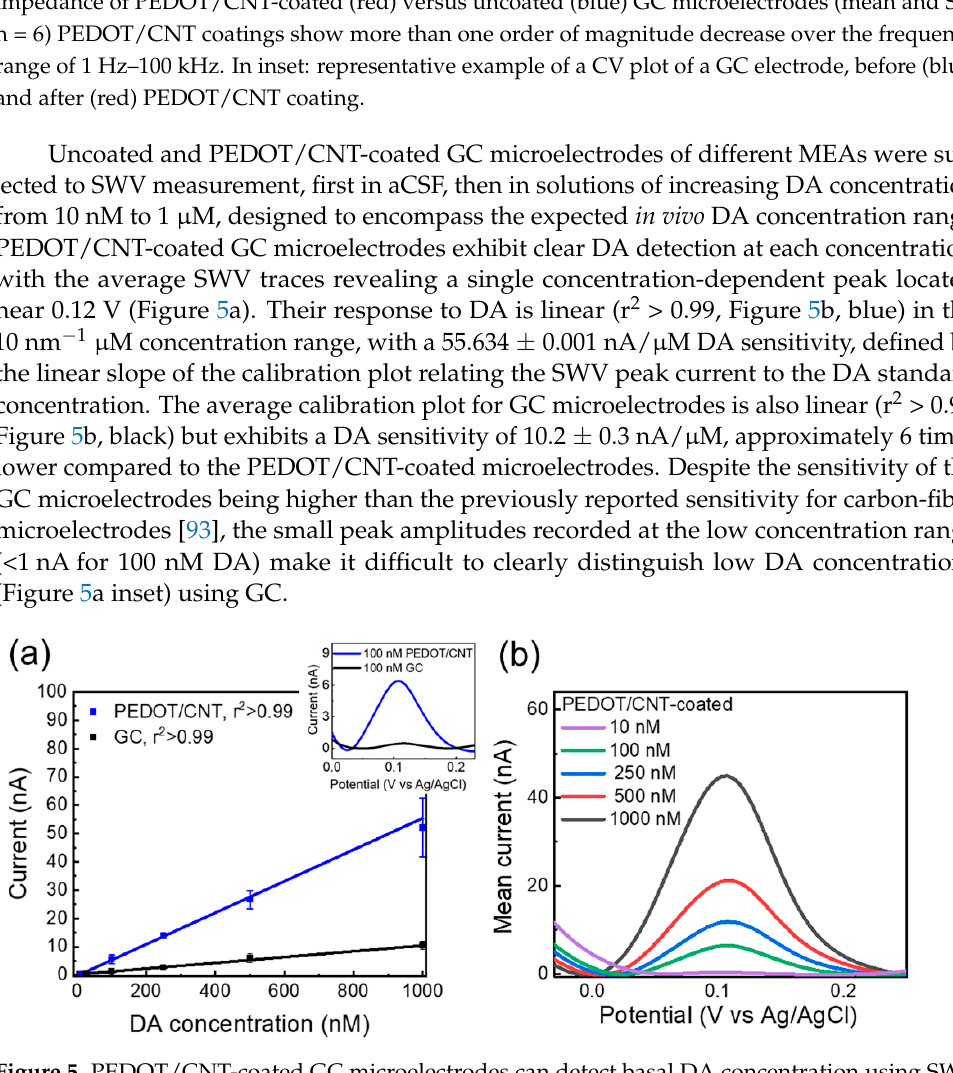
Figure 5. PEDOT/CNT-coated GC microelectrodes can detect basal DA concentration using SWV. ( a ) Average (±SD) DA calibration plot (peak current vs. DA concentration, n = 5) conducted at PEDOT/CNT-coated GC microelectrodes in comparison with the calibration plot obtained using GC microelectrodes (n = 4). The average sensitivity, defined as the linear slope of the calibration plot, is linear in the range of 10 nM–1 μ M, and it is 5.6 times higher (55.634 ± 0.001 nA/ μ M) than the one obtained using uncoated GC microelectrodes (10.22 ± 0.33 nA/ μ M). In inset: representative baseline-subtracted SWV DA peaks collected from a PEDOT/CNT-coated microelectrode (blue) and GC microelectrodes (black). ( b ) In vitro SWV DA calibration conducted at PEDOT/CNT-coated GC microelectrodes in aCSF reveals clear DA peaks at 0.12 V.